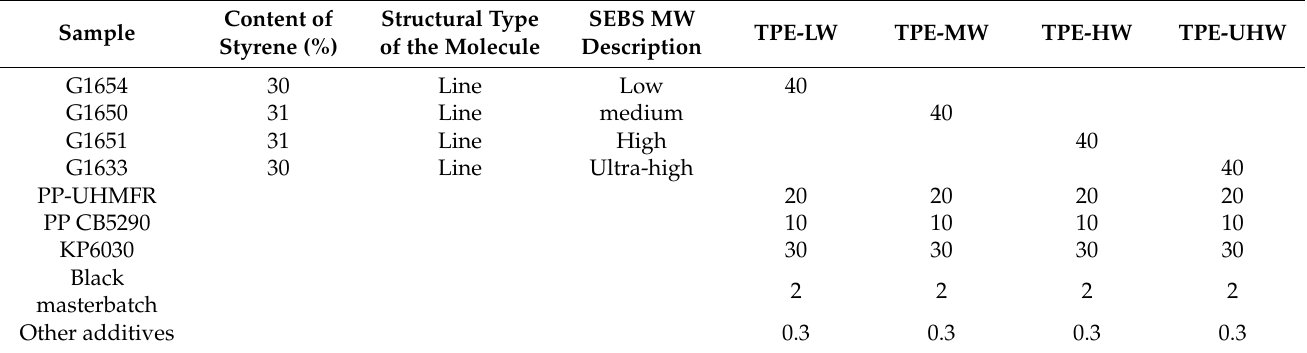
Table 1. Formulas of TPE prepared by SEBS with similar structure and various molecular